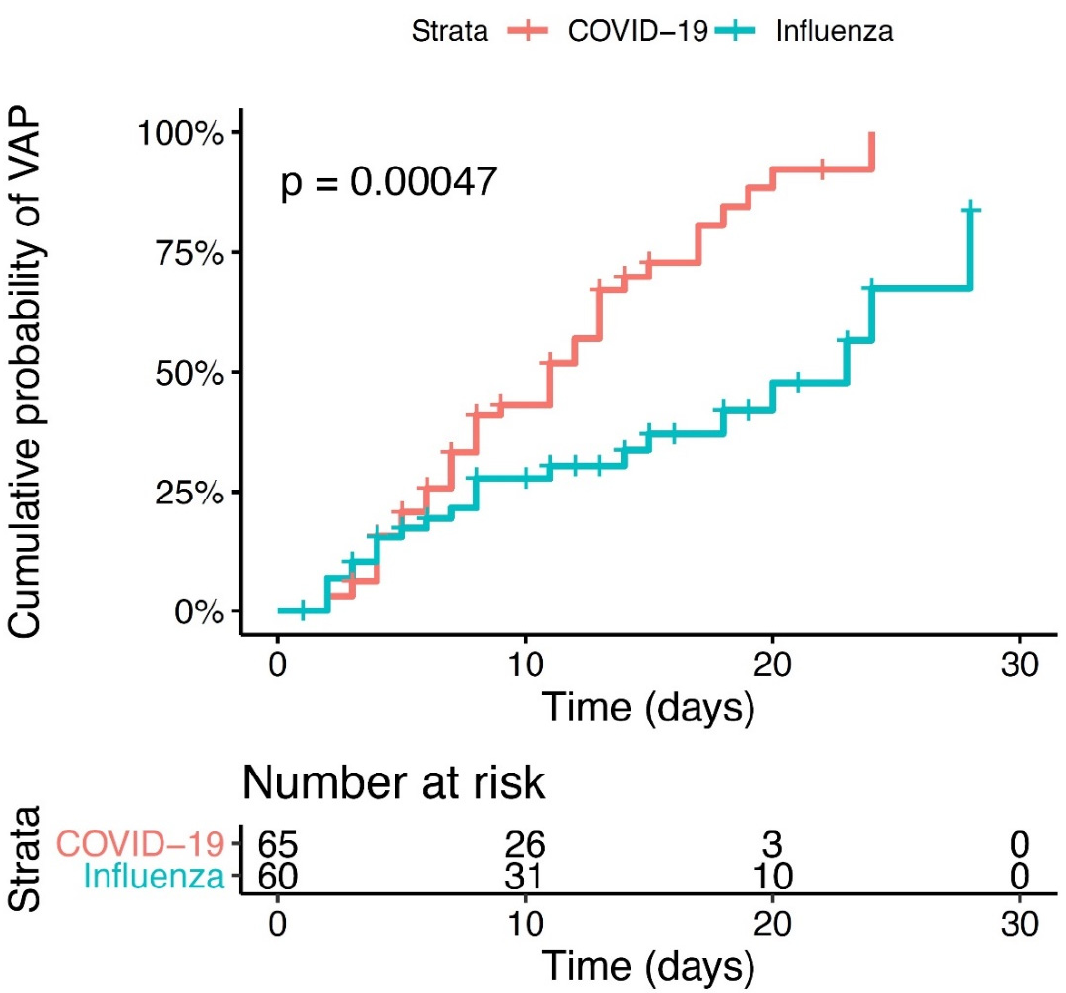
Figure 2. Cumulative probability of VAP. Kaplan Meyer survival analysis from intubation to day 28. Patient with COVID-19-ARDS (red line) or H1N1-ARDS (blue line). p < 0.0047.